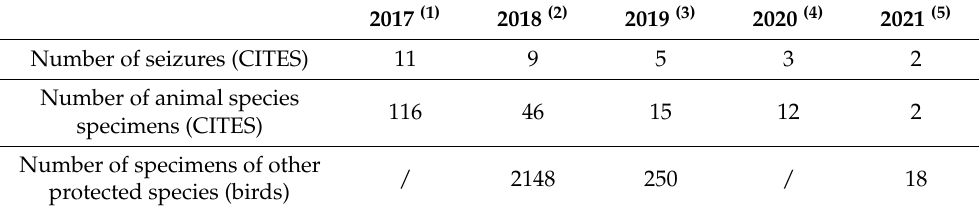
Table 2. The extent of animal trade in Slovenia in a 5-year